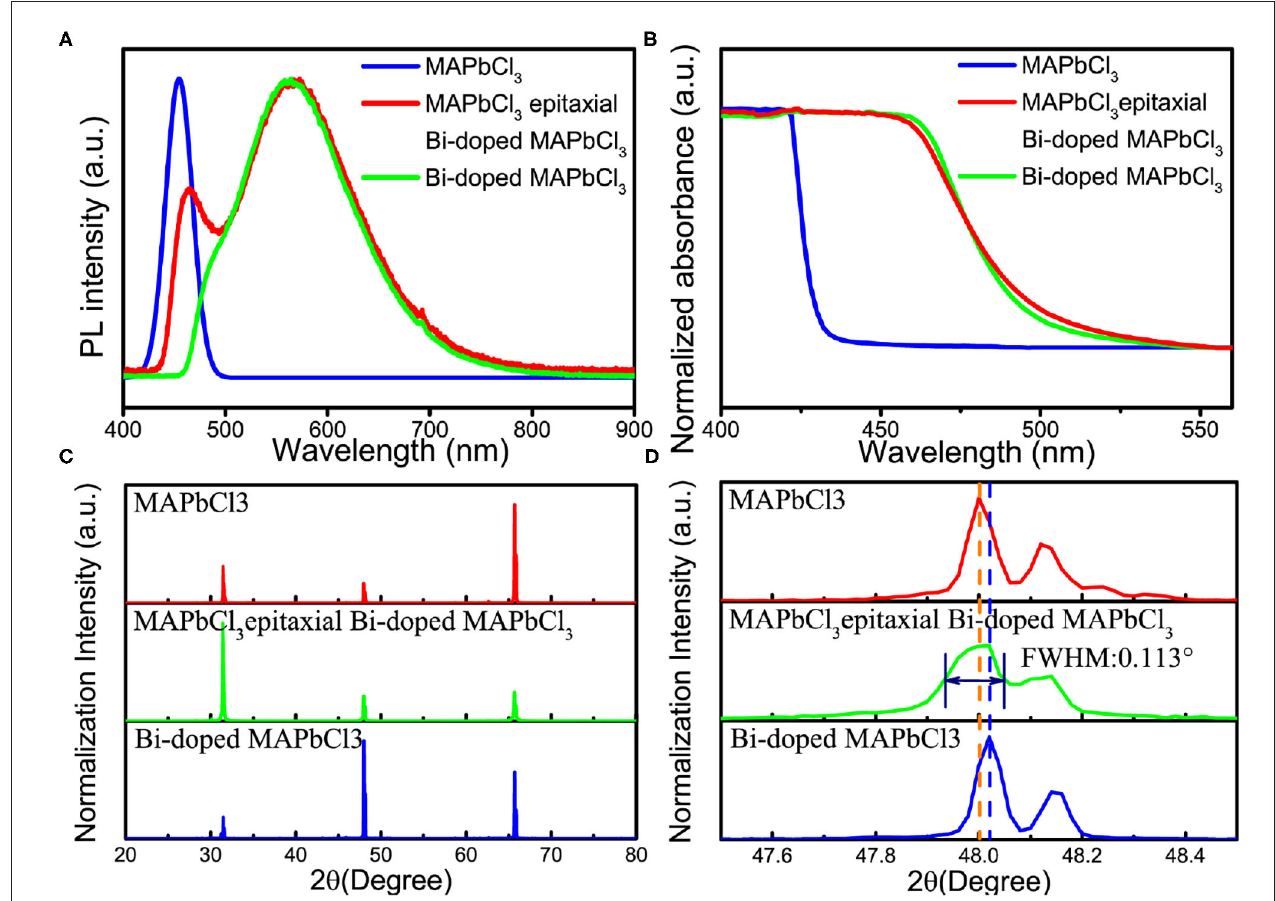
FIGURE 2 | (A) PL spectra of pristine MAPbCl 3 substrate, MAPbCl 3 with epitaxial layer, and Bi-doped MAPbCl 3 . (B) Absorption of pristine MAPbCl 3 substrate, MAPbCl 3 with epitaxial layer, and Bi-doped MAPbCl 3 . (C) XRD spectra of the pristine MAPbCl 3 substrate, MAPbCl 3 with Bi-doped MAPbCl 3 epitaxial layer, and Bi-doped MAPbCl